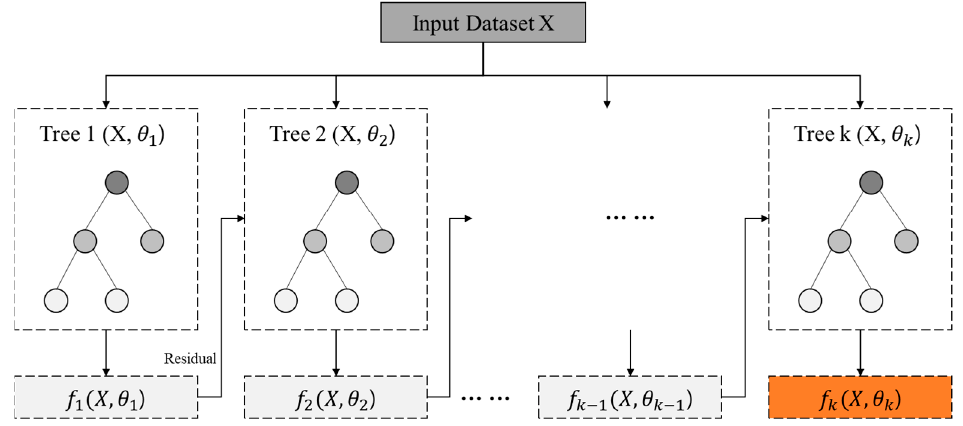
Figure 4. XGBoost model process.